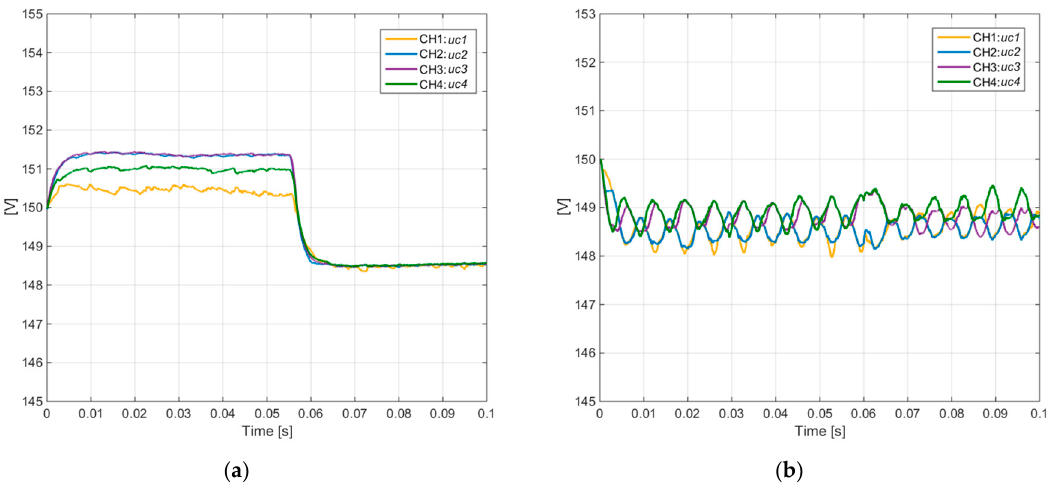
Figure 8. Capacitor voltage balancing during the step transition of: ( a ) Figure 6 and ( b ) Figure 7, CH1: u C 1 ; CH2: u C 2 ; CH3: u C 3 ; CH4: u C 4 ; 1 V/div; 10 ms/div.